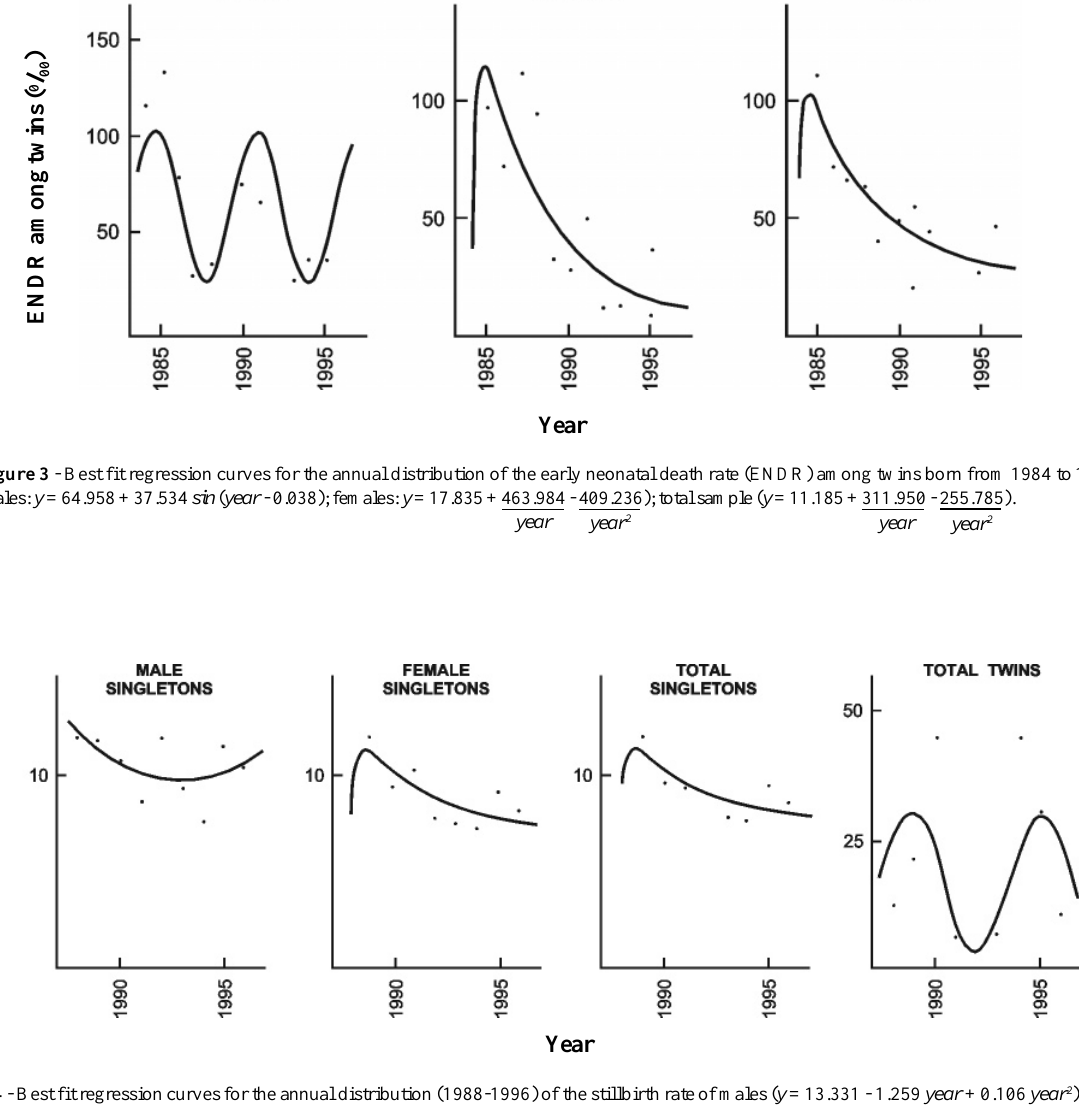
Figure 4 - Best fit regression curves for the annual distribution (1988-1996) of the stillbirth rate of males ( y = 13.331 - 1.259 year + 0.106 year 2 ), females ( y = 5.643 + 19.991 - 17.389) and total sample of singletons ( y = 7.134 + 16.254 - 13.008), as well as of twins [ y = 16.709 + 13.213 sin ( year - 0.239)].